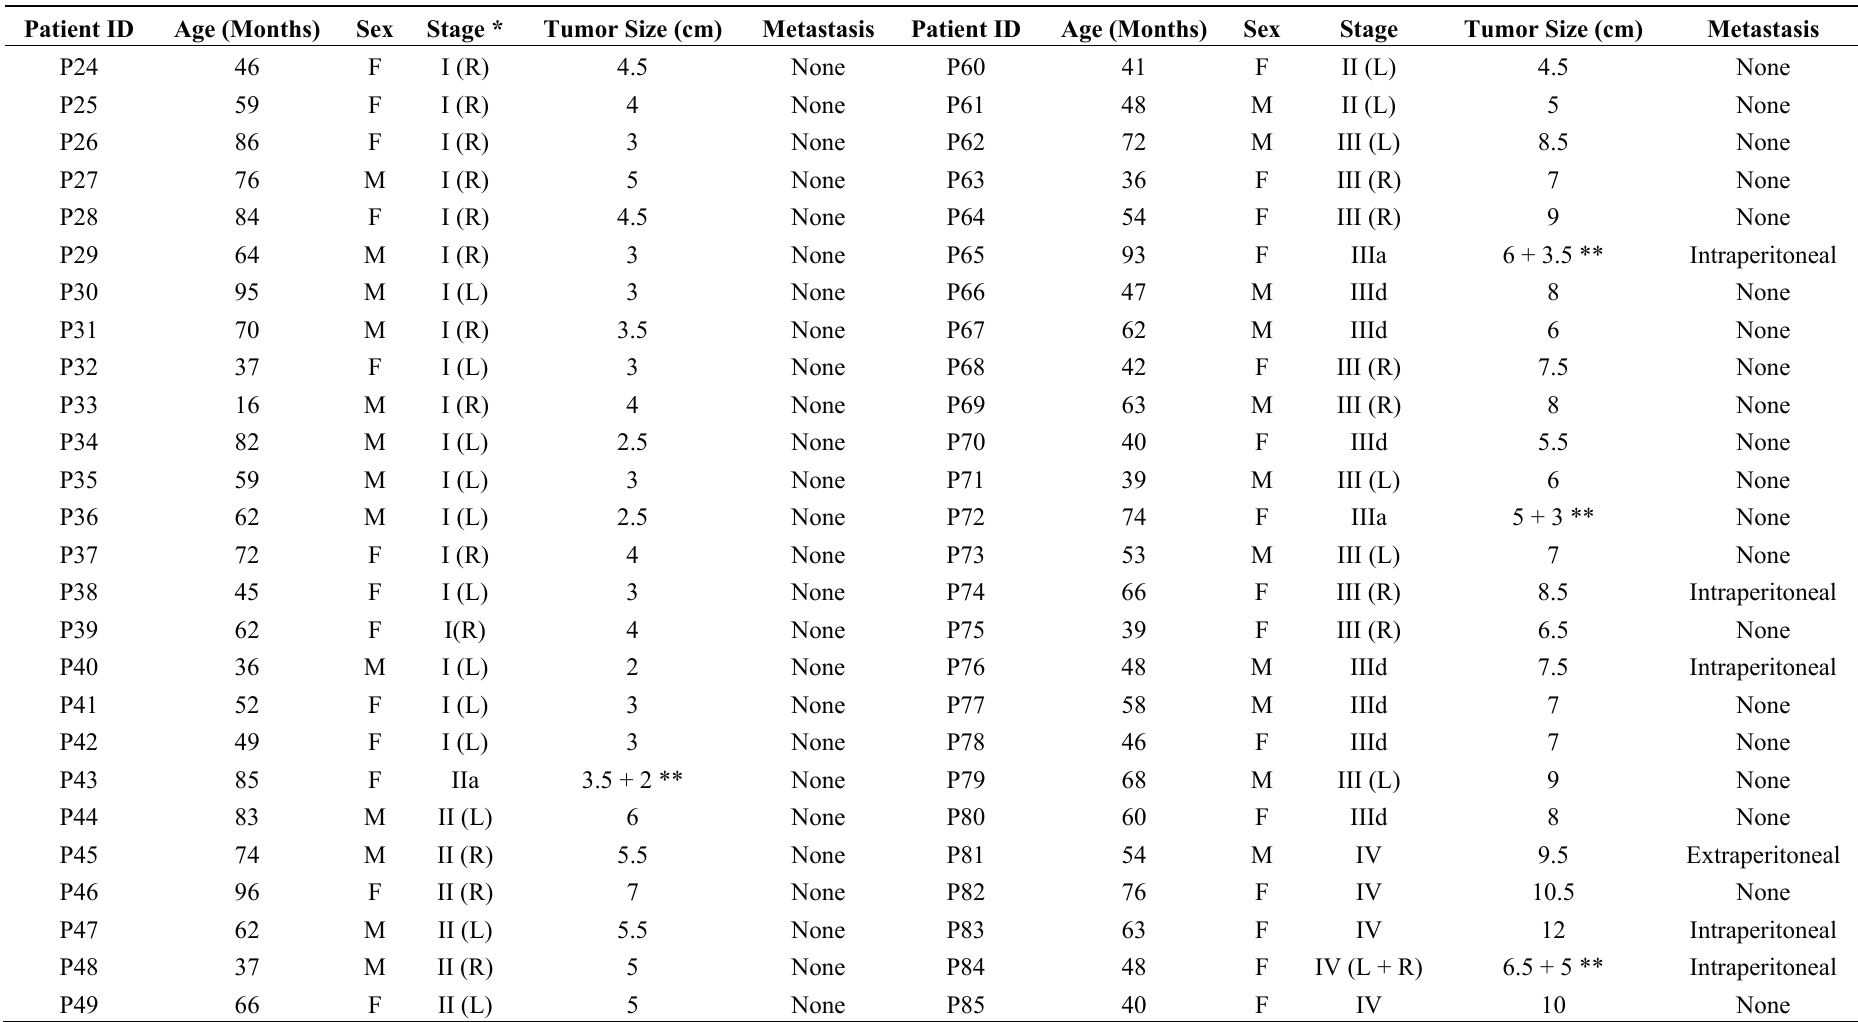
Table 7. Amino acid sequence of the full-length protein obtained by matching and recombination of